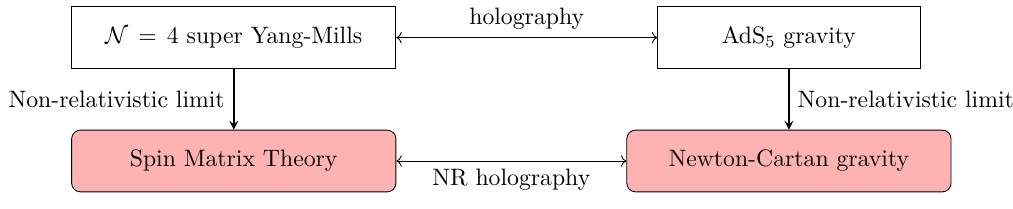
Figure 1 . The holography between SMT and Newton-Cartan gravity can be viewed as the non- relativistic limit of the holography between